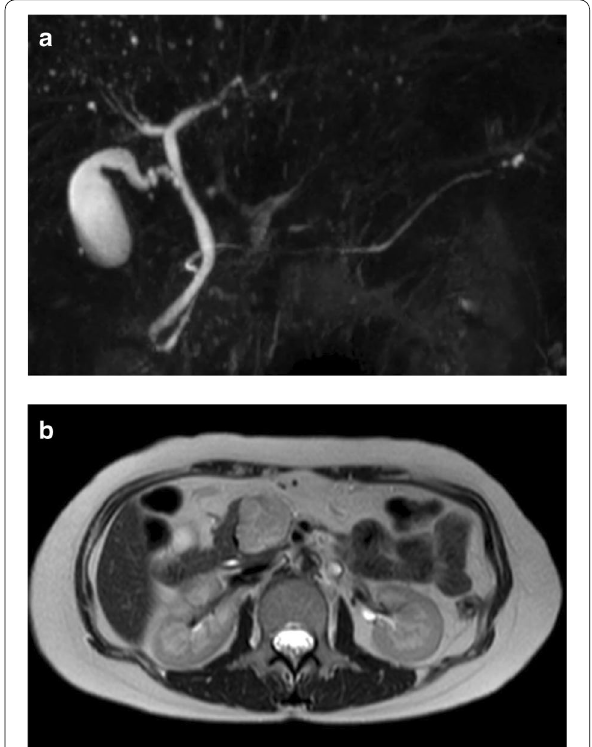
Fig. 2 MR images. a Magnetic resonance cholangiopancreatography (MRCP) demonstrating an intact main pancreatic duct. b T2-weighted MR highlighting the tumor as a high signal area Fig. 3 Endoscopic ultrasonography (EUS). a EUS illustrating a